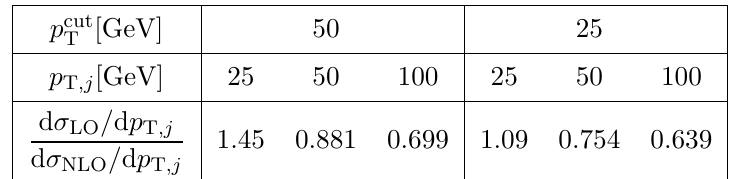
cut = 50 GeV T for p T restricted to T